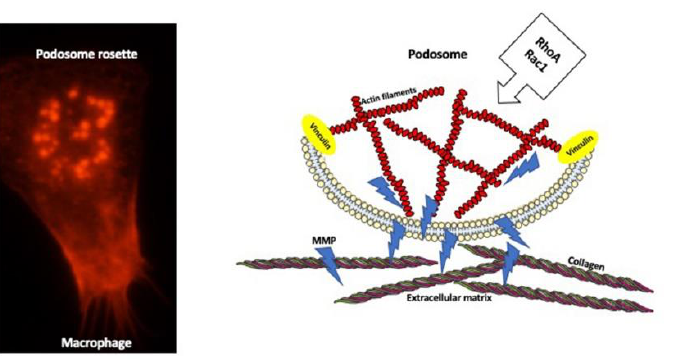
Figure 3. Podosome structure and function. Microscope image of mouse macrophage stained for actin (red color) shows podosomes arranged into a rosette ( left panel ). The diagram of the longitudinal section through the podosome ( right panel ) depicting the actin filament core surrounded by the adhesion molecules such as vinculin, which anchor actin filaments at the membrane. Podosome delivers matrix metalloproteinase enzymes (MMPs) that digest extracellular matrix components such as collagen.